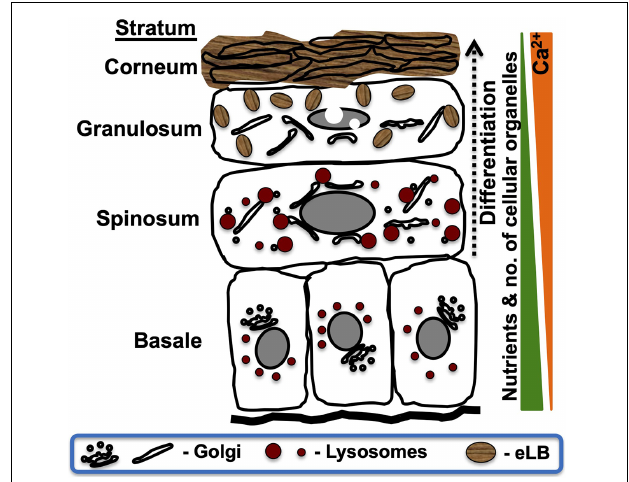
FIGURE 1 | Schematic representation of intracellular organelle dynamics in the epidermal sublayers. The human epidermis is composed of four functionally distinct sublayers formed by variable differentiation states of keratinocytes. Alterations in the extracellular composition and intracellular organelles of keratinocytes are represented according to the established studies (reviewed in Bikle et al., 2012). Stratum basale contains proliferative keratinocytes having all intracellular organelles similar to other cell types. These cells undergo differentiation (dotted arrow) after each cycle of asymmetric cell division and modify the Golgi organization and disperse lysosomes that result in the formation of the spinosum layer (Monteleon et al., 2018; Mahanty et al., 2019; Yamanishi et al., 2019). These cells are further subjected to late-stage differentiation and gradually lose their intracellular organelles while generating a new set of organelles called lamellar bodies (eLBs), which form the granulosum layer. These eLBs undergo exocytosis and generate the lipid sheets/barrier. Lastly, the cells of the granular layer undergo terminal differentiation, which forms SC (reviewed in Bikle et al., 2012). These cells are also called corneocytes (lack intracellular organelles) that remain embedded in lipid sheets produced by eLBs of the granular layer. The sequential changes in intracellular organelle dynamics, including the nucleus, are shown in the sublayers of skin (Akinduro et al., 2016). Extracellular ascending calcium gradient (Ca 2 + ) and a descending nutrient gradient exist from the base of the epidermis. Note that the deformation of the nucleus initiates at the spinosum layer and eliminated through nucleophagy in the upper layers of the epidermis.